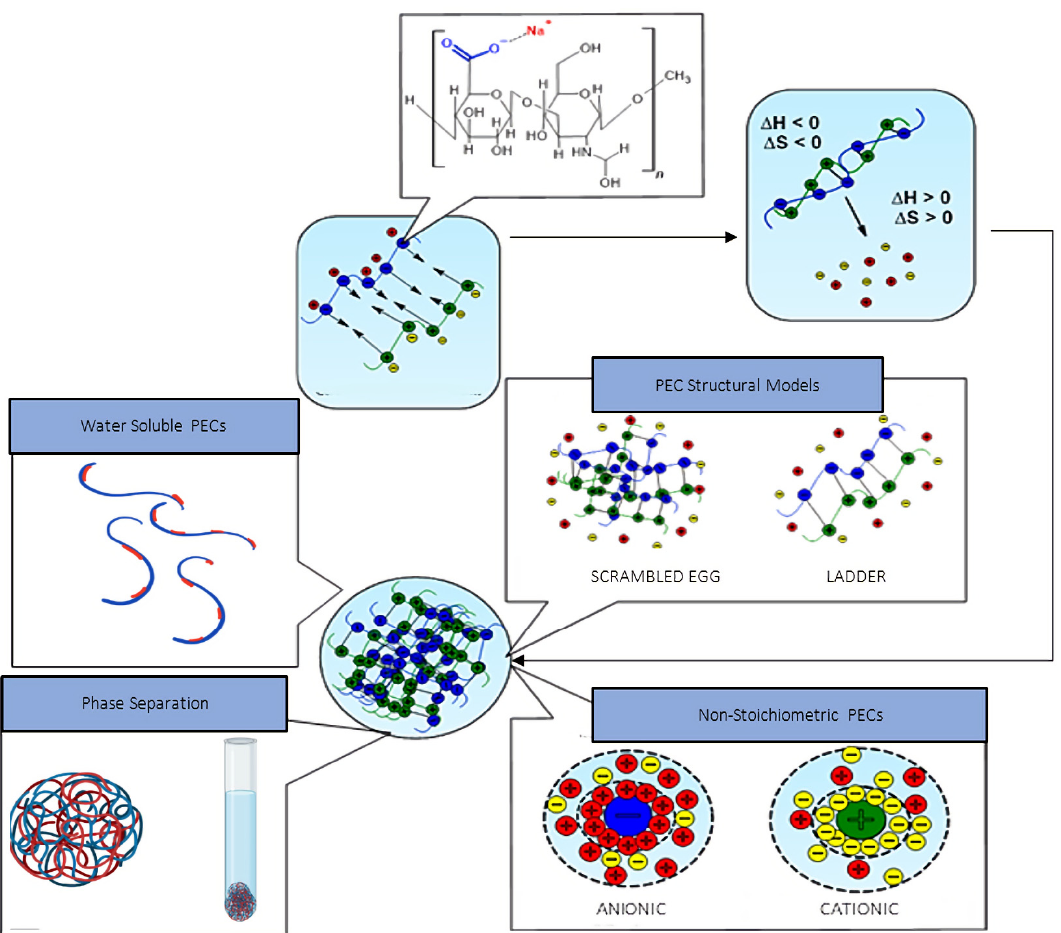
Figure 3. An overview of the complexation between HA and a cationic polyelectrolyte with the resulting physiochemical attribute-dependent structural models (blue—carboxylate anion, red— cationic counterion, green—cationic polyelectrolyte, yellow—anionic counterion; Δ H—change in enthalpy, Δ S—change in entropy) (Created using Biorender.com [196]).